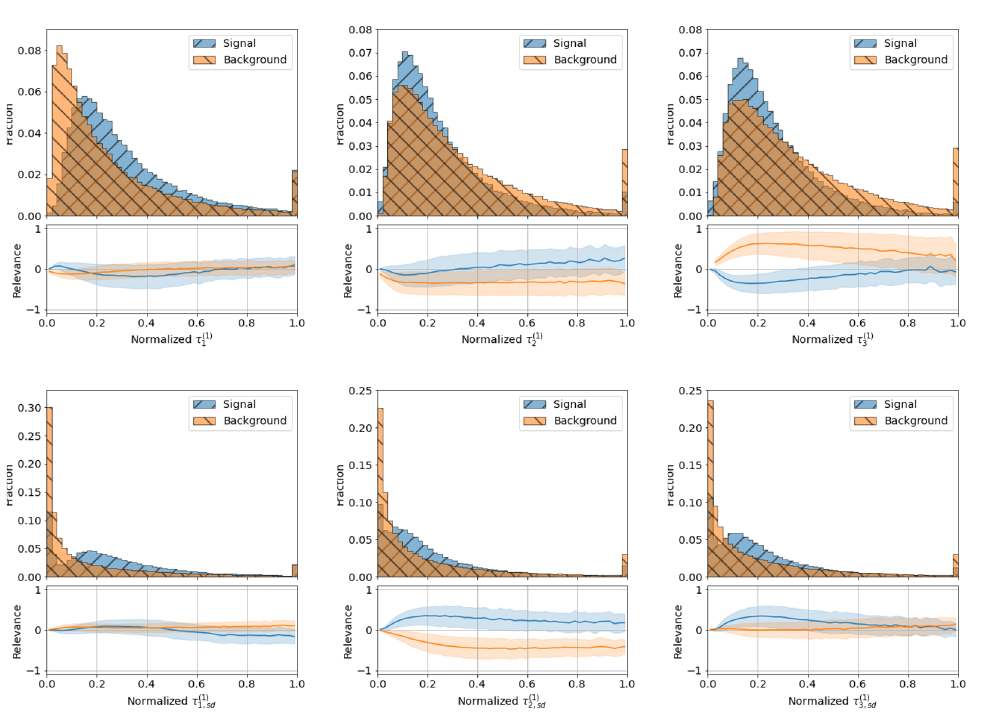
Figure 28. Histograms with profiles of normalized LRP relevances.